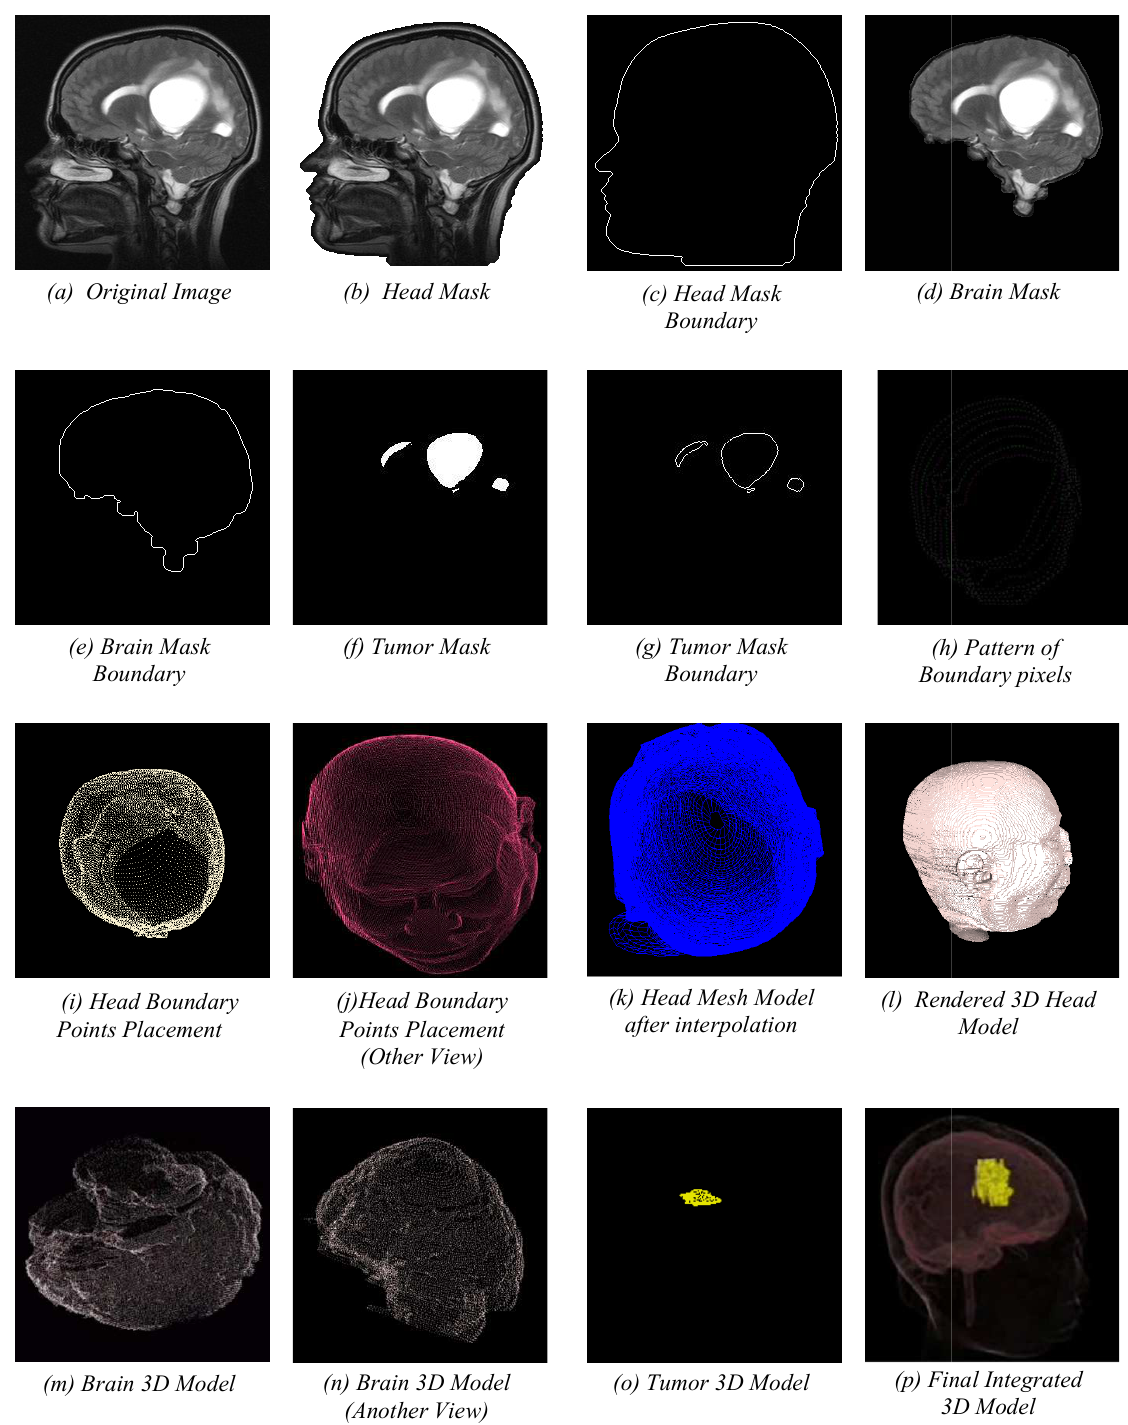
Fig.12 Extraction of Head, Brain and Tumor Boundaries and their 3D